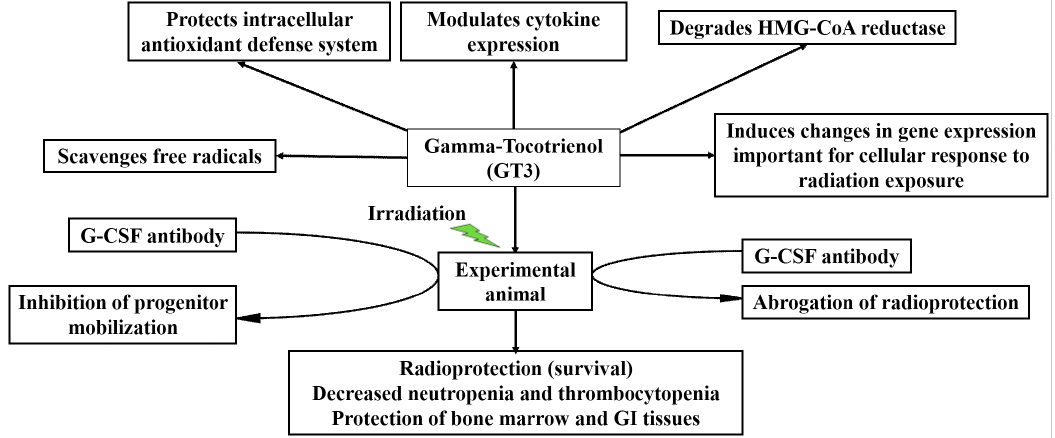
Figure 5. Potential mechanism of action for GT3 for its radioprotective